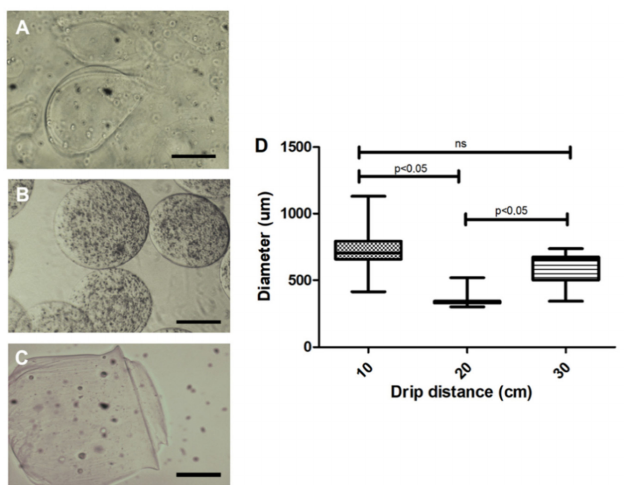
Figure 2. E ff ect of the microdrop distance of the 3% sodium alginate solution on microcapsule morphology. ( A ) A 10 cm distance presented variability in shape and larger diameters (710 ± 135 µ m); ( B ) A 20 cm distance presented a more homogeneous shape and smaller diameter (364 ± 65 µ m); ( C ) A 30 cm distance cm displayed an average diameter of 593 µ m with more heterogeneous forms; ( D ) Quantification of the diameter of the capsules in relation to the distance of the drip. Photos recorded using light field optical microscope; Five independent experiments were performed in triplicate. 200 µ m bar. Values were considered statistically significant when p < 0.05. ns = non-significant.